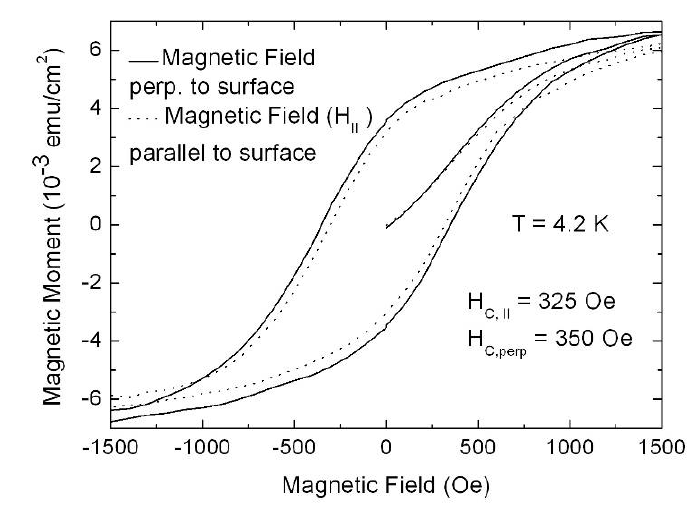
Figure 43. Hystereses loops of a PS-matrix impregnated with a magnetite-solution. The measurements have been carried out for easy axis and hard axis magnetization, perpendicular (full line) and parallel (dotted line) to the sample surface. The small anisotropy is mainly caused by the morphology of the used PS-template leading to predetermined stronger coupling of particles situated along one pore (reproduced by permission of The Electrochemical Society